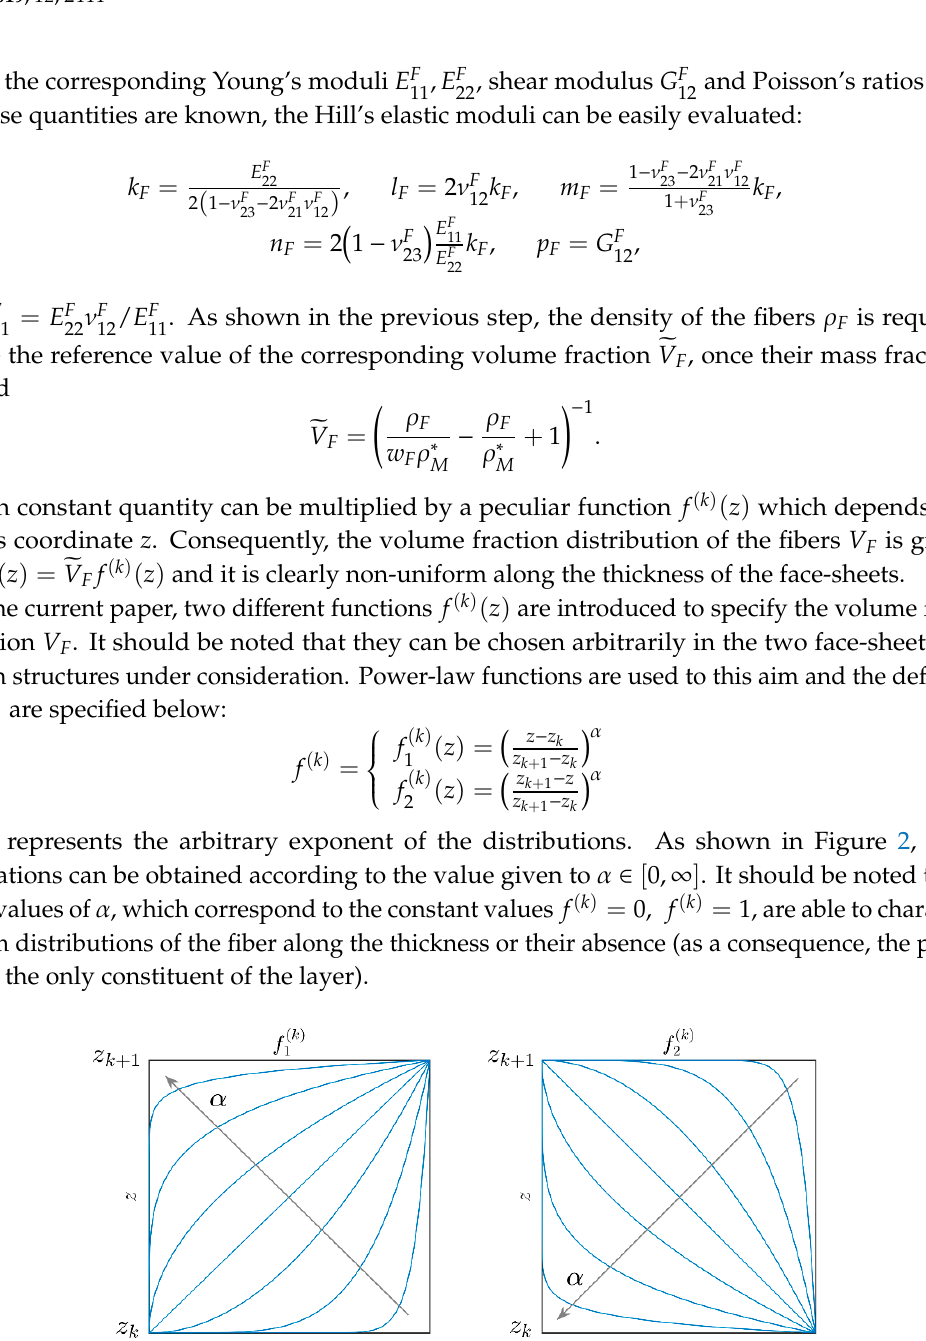
Figure 2. Through-the-thickness representation of the function f ( k ) employed to characterize the volume fraction distribution of the fibers in the k -th layer of the plate, for increasing values of the exponent α : ( a ) f ; ( b ) f .